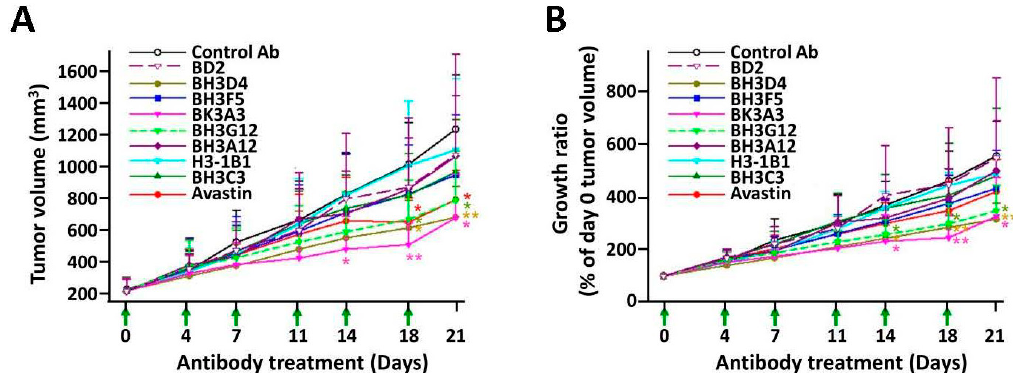
Figure 4. Tumor growth inhibition experiment in xenograft model. ( A ) Antitumor activity on human COLO 205 cancer cell xenografts of Avastin and test antibodies were measured by Day 21 tumor volume. Anti-VEGF antibodies were administered intraperitoneally (i.p.) twice per week for three consecutive weeks. Data points indicate mean ± SD of tumor volume ( n = 6, except n = 5 in Avastin group). The statistical analysis was performed by Student t -test. The single star represents p < 0.05, whereas the double star represents p < 0.01; ( B ) The trend of tumor growth ratio. Anti-VEGF antibodies at the concentration of 0.1 mg/kg were administered i.p. twice per week for three weeks. Data points indicate mean ± SD of tumor growth ratio ( n = 6, except n = 5 in Avastin group). The statistical analysis was performed by Student t -test. The single star represents p < 0.05, whereas the double star represents p < 0.01.